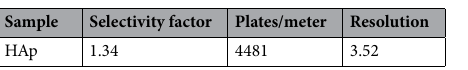
Table 3. Column separation parameters of HAp